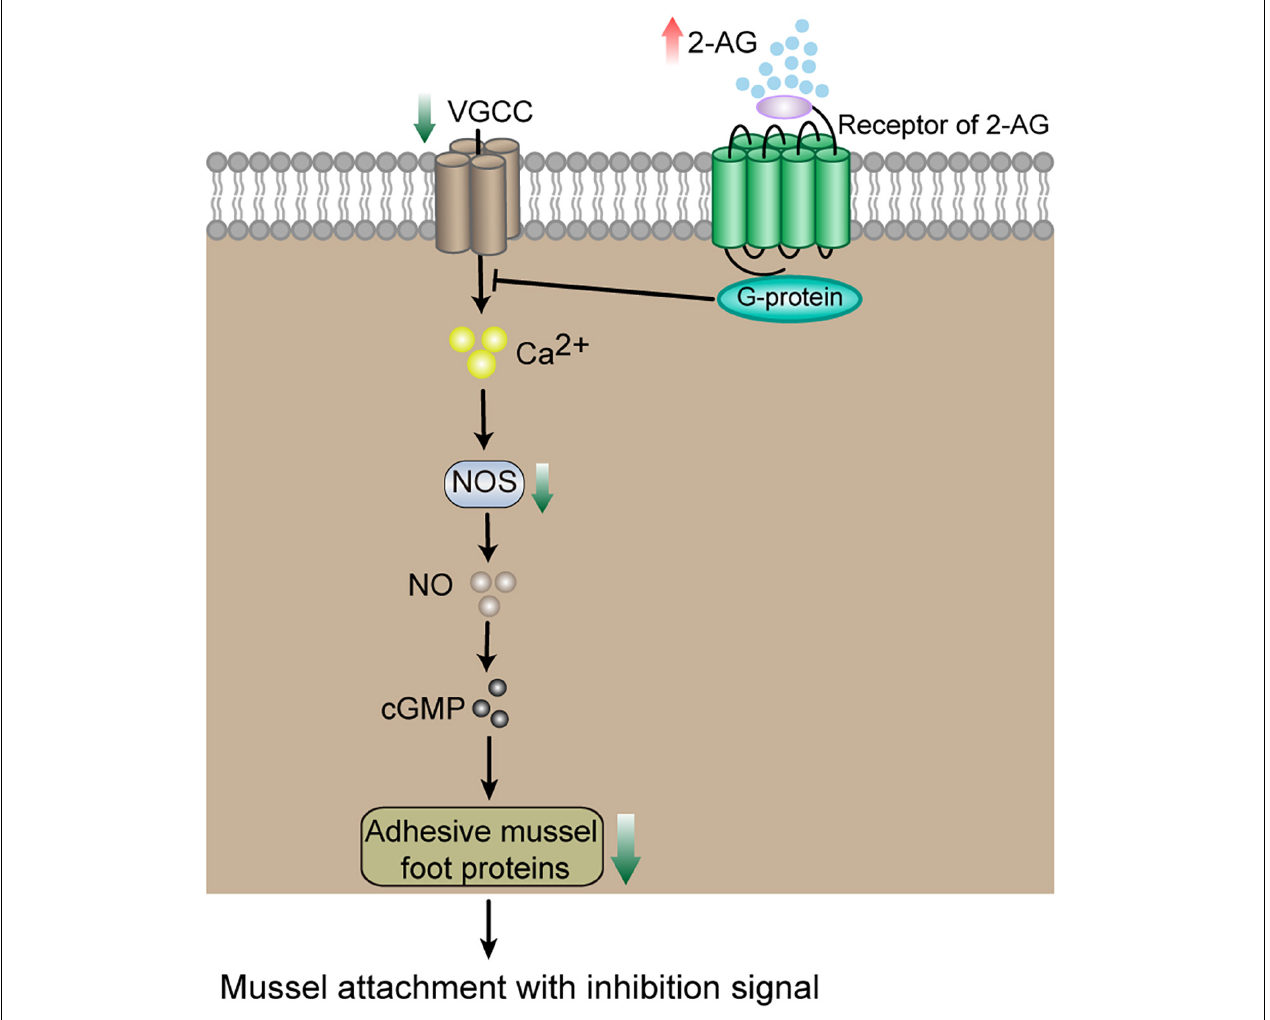
FIGURE 5 | A suggested pathway for the inhibitory effect of 2-AG on mussel attachment based on transcriptomic data. Red arrows indicate higher levels. Green arrows indicate lower